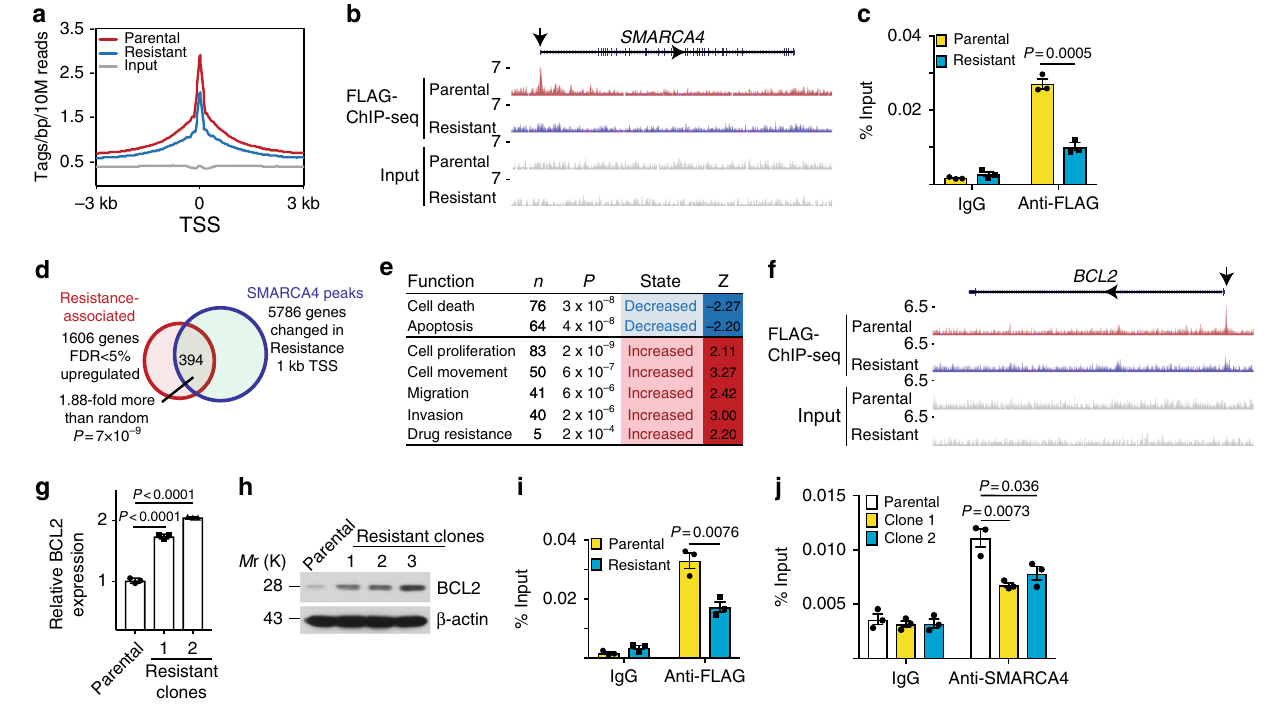
Fig. 3 SMARCA4 loss promotes resistance to EZH2 inhibitors by upregulating an anti-apoptosis gene signature. a ChIP-seq pro fi les of SMARCA4 in parental and resistant cells. TSS: transcription starting sites. b ChIP-seq tracks of SMARCA4 on its own promoter region in endogenously FLAG-tagged parental and resistant cells. Arrow points to the loss of SMARCA4 binding in its own promoter region. c ChIP-qPCR validation of a decrease of SMARCA4 binding to its own promoter. d Venn diagram showing the genome-wide overlap analysis between SMARCA4 ChIP-seq and genes upregulated in RNA-seq in parental and resistant cells. e Top pathways enriched among the genes identi fi ed in d . f ChIP-seq tracks of SMARCA4 on the BCL2 promoter region in endogenously FLAG-tagged parental and resistant cells. g , h qRT-PCR ( g ) and immunoblot ( h ) of BCL2 levels in parental and resistant cells. i , j ChIP-qPCR validation of a decrease in SMARCA4 binding on the BCL2 promoter in resistant cells using antibodies against endogenously tagged FLAG ( i ) or endogenous SMARCA4 ( j ). Data represent mean ± S.E.M. of three independent experiments ( c , g – j ). P -value was calculated via two-tailed t